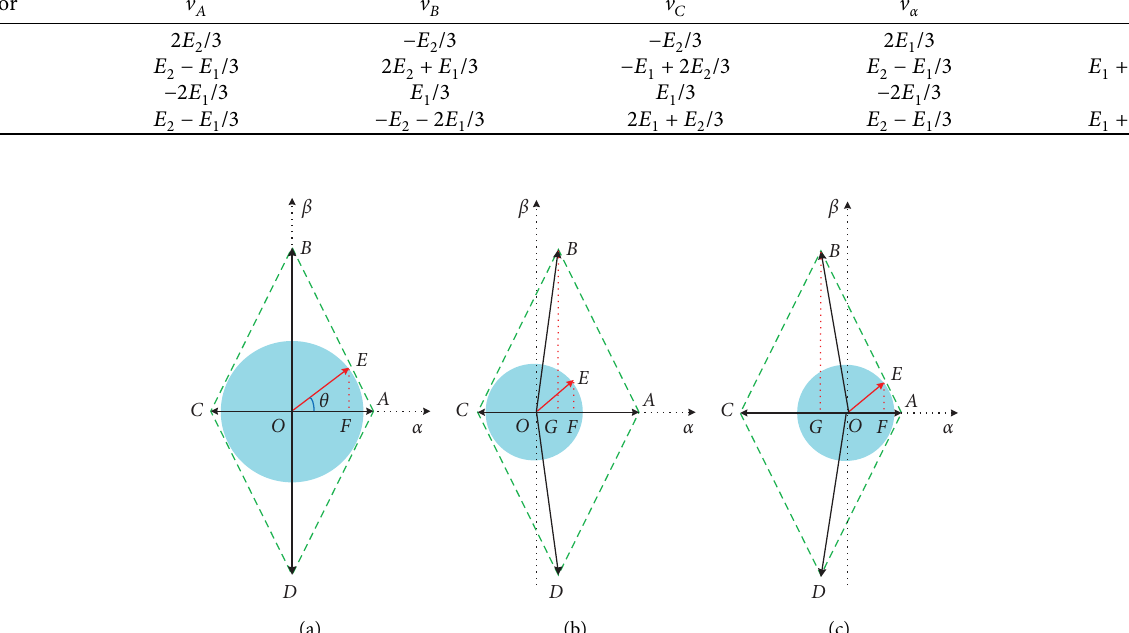
Table 1: Te four possible voltage vector values for the FSTPR in the stationary reference frame.